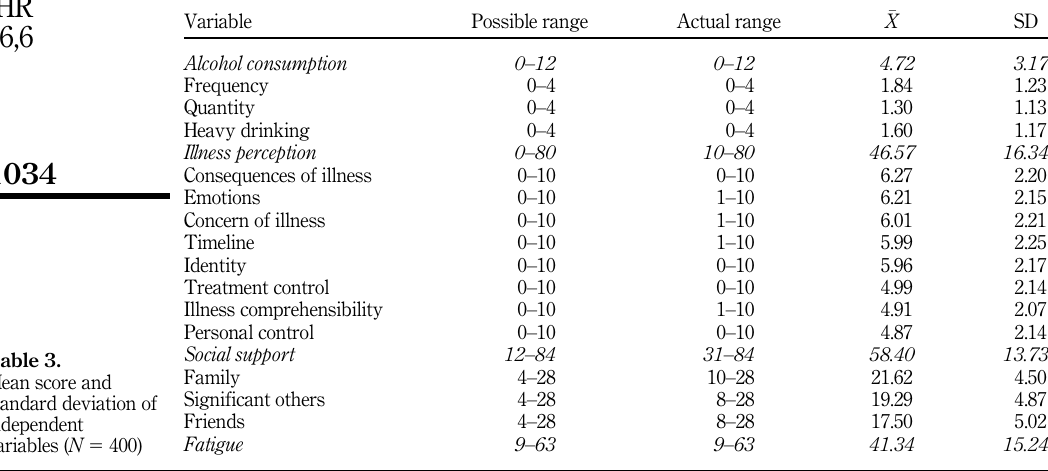
Table 3. Mean score and standard deviation of independent variables ( N 5